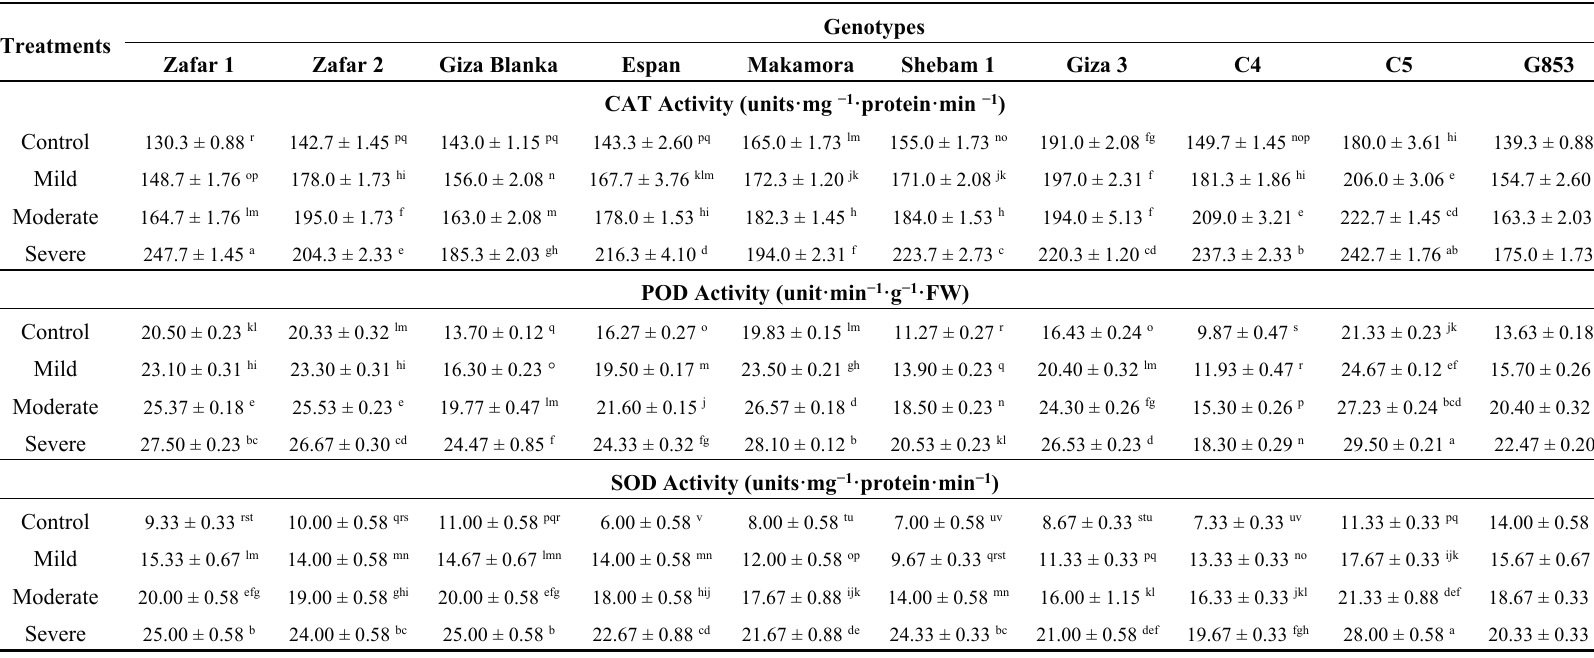
Means followed by a similar letter within a column for each parameter are not significantly different at the 0.05 level of probability by Duncan's Multiple-Range